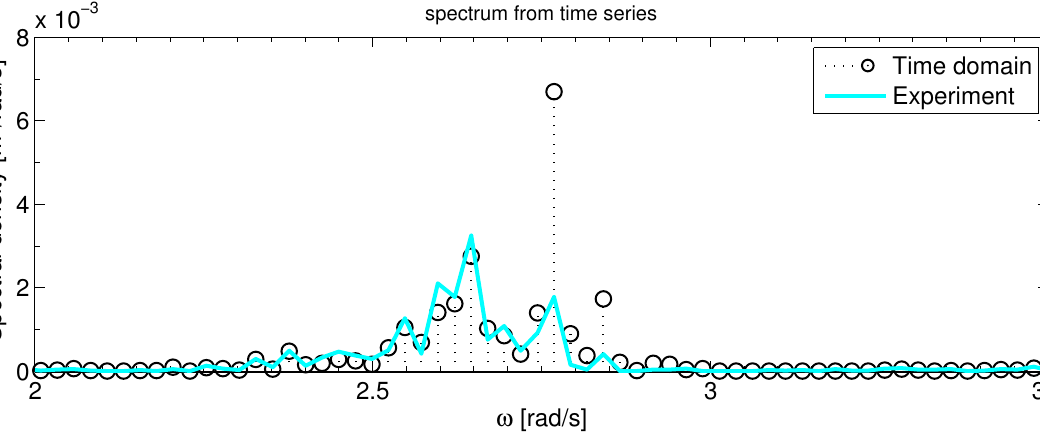
Figure 8. Spectral density of heave response (root mean squared error (RMSE) of computed and experimental results = 3.9 × 10 − 5